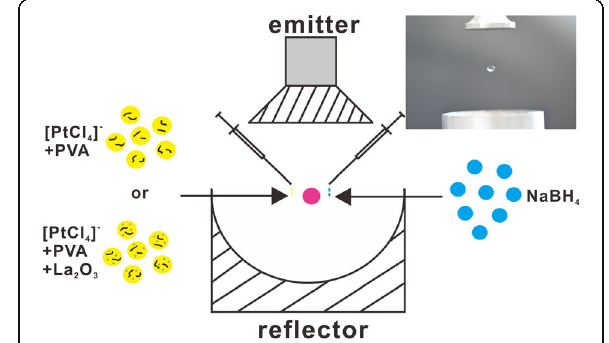
Fig. 7 Schematic view of the experimental setup of the acoustic